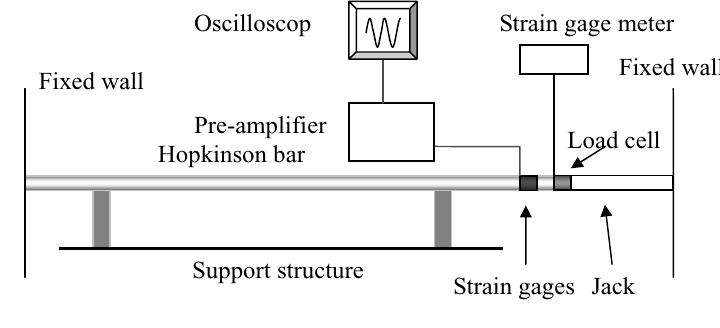
Fig. 6. Schematic for the Hopkinson bar